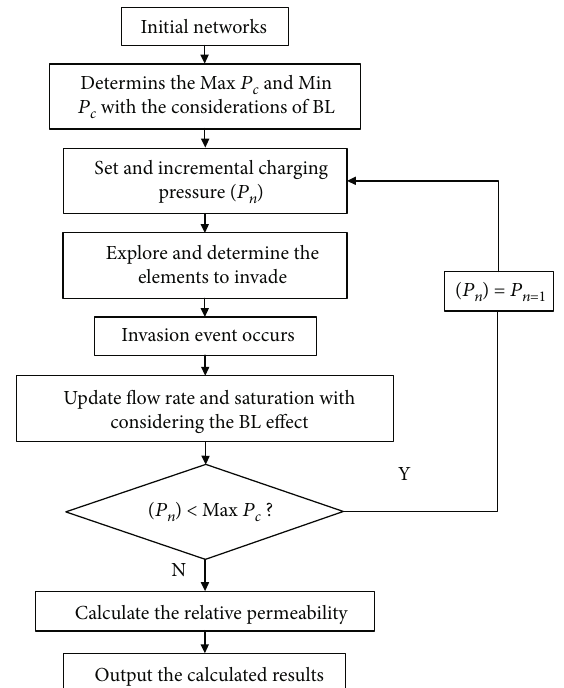
Figure 2: A work fl ow for quasistatic fl ow modeling of oil migration with consideration of the BL e ff